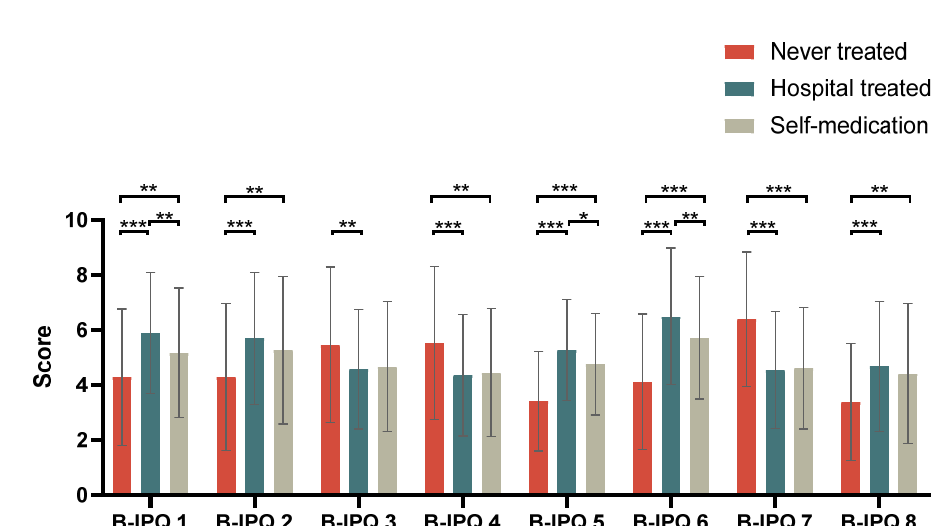
Figure 1. Comparison of B-IPQ item scores among participants with respiratory allergies in different health-seeking-behavior groups. Abbreviation: B-IPQ, Brief Illness Perception Questionnaire. * p <